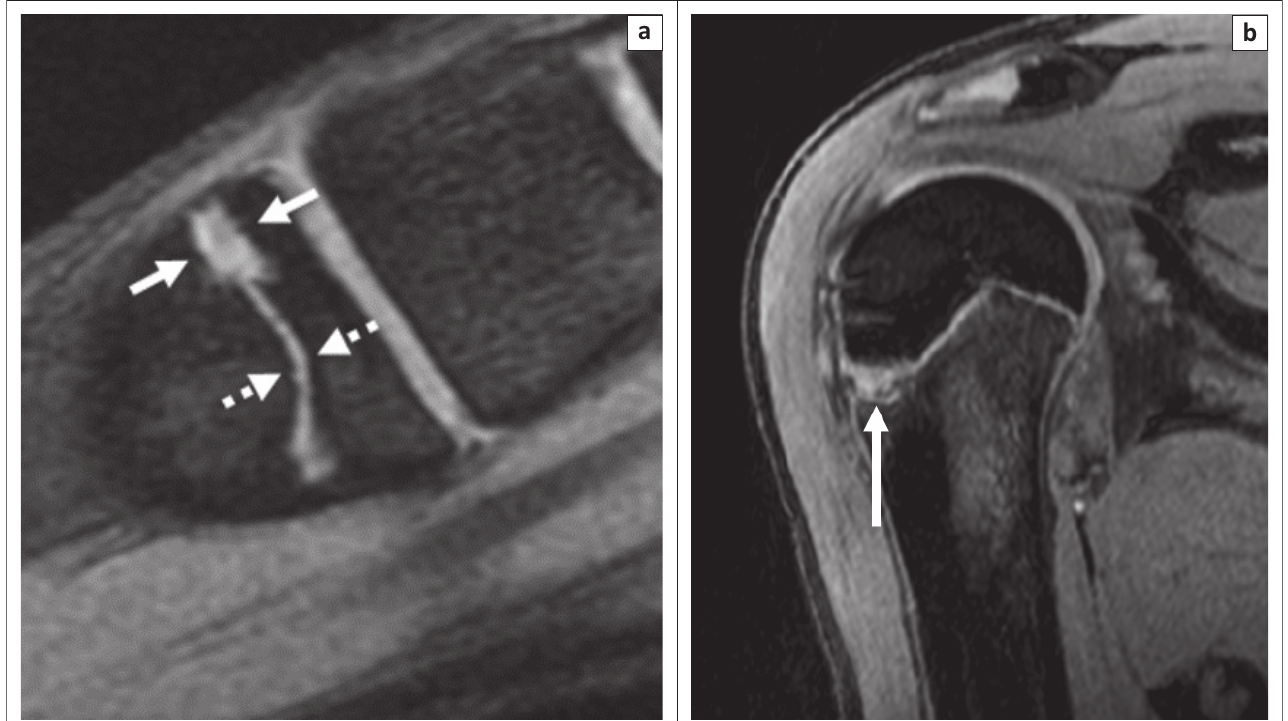
FIGURE 3: Chronic physeal stress on magnetic resonance imaging. (a) Sagittal gradient echo magnetic resonance image (959/14 ms, 20° flip angle) of the great toe in the same girl delineates abnormal widening of the dorsal physis (solid arrows) relative to the normal plantar physis (dotted arrows). The signal intensity is similar between the normal and the abnormal portions of the physis. (b) Sagittal volumetric gradient echo magnetic resonance image (13.9/5.2 ms, 30° flip angle) of the proximal right humerus of a 12-year-old male baseball player shows a focal region of abnormal widening (arrow) of the lateral aspect of the proximal humeral physis, with a configuration similar to the great toe metatarsal physis in the patient shown in Figure 2. This so-called ‘Little Leaguer’s shoulder’ is another example of physeal stress change attributed to a chronic traction injury.